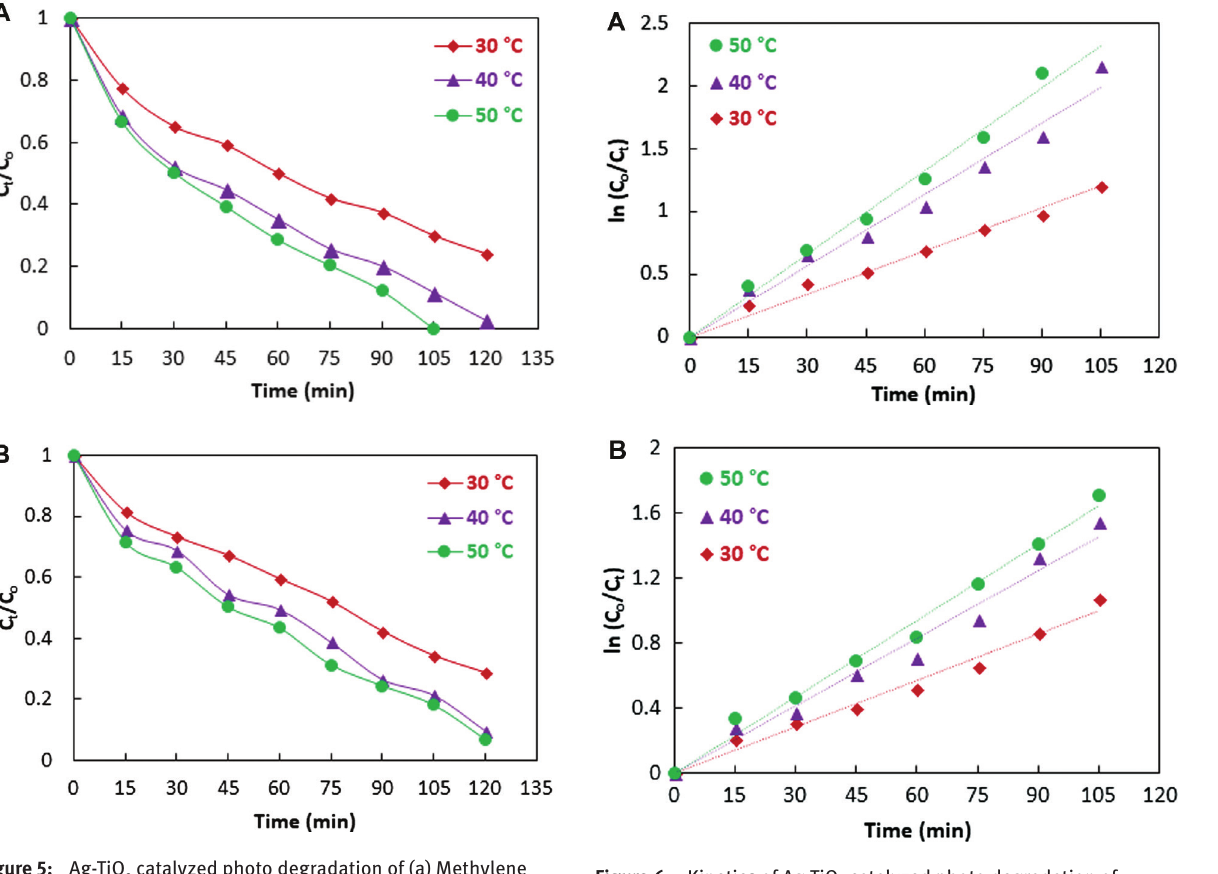
Figure 6: Kinetics of Ag-TiO (a) Methylene blue dye and (b) Rhodamine B dye, both at various